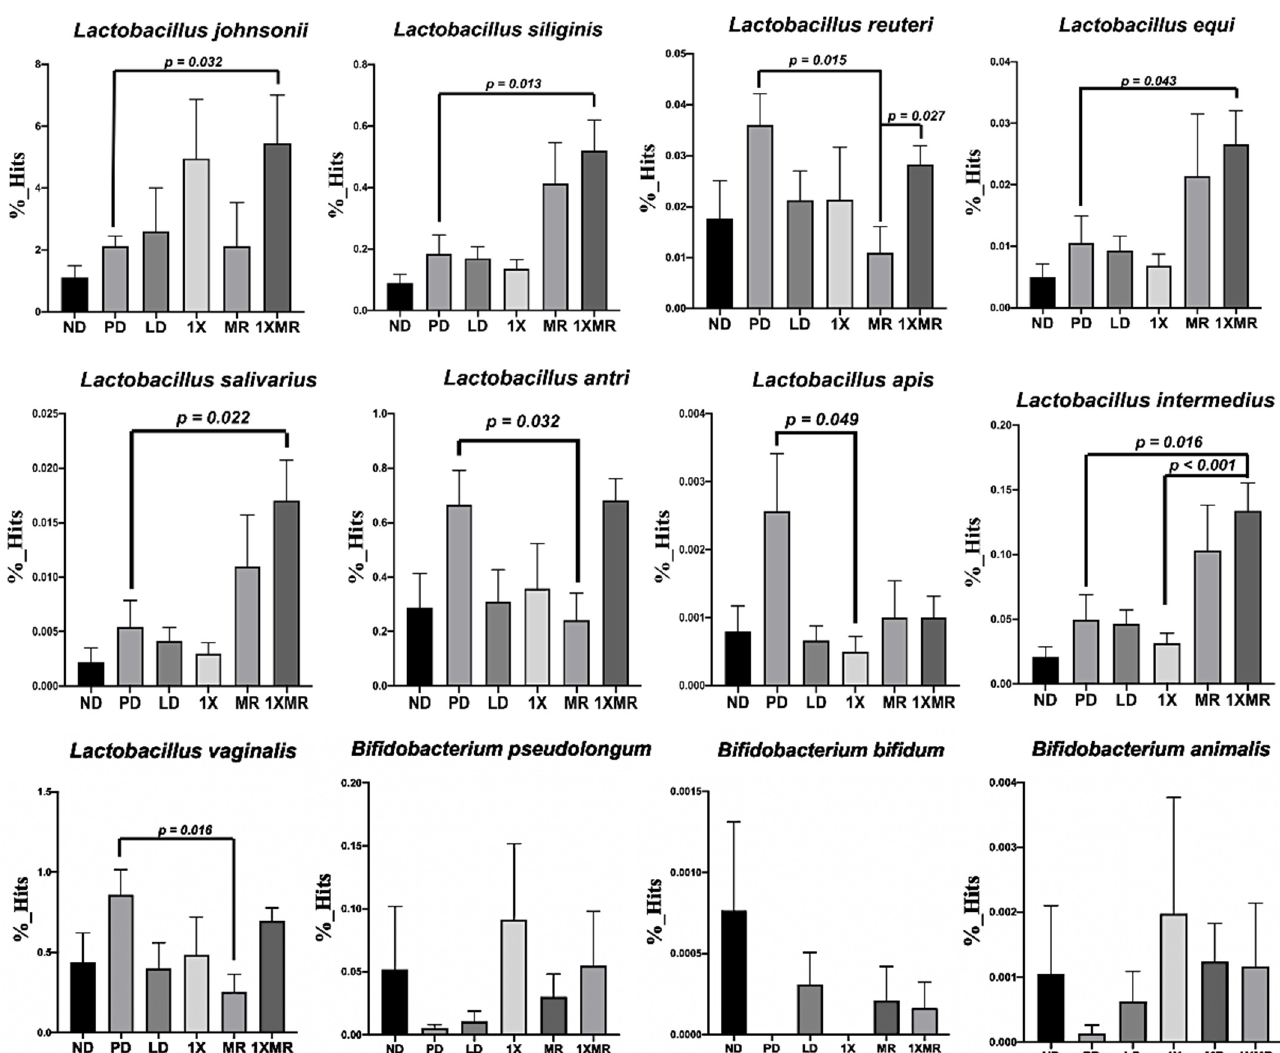
Figure 6. Comparison of specific bacteria identified in rats with 6-OHDA-induced lesions after 8 weeks of 1X, MR, and 1XMR treatment. Values are reported as mean ± SEM for 5 rats per group. ND, non-diseased; PD, untreated PD; LD, PD treated with 8 mg of L-DOPA; 1X, PD supplemented with the probiotic; MR, PD supplemented with MR as prebiotic; 1XMR, PD supplemented with a combination of 1X and MR.